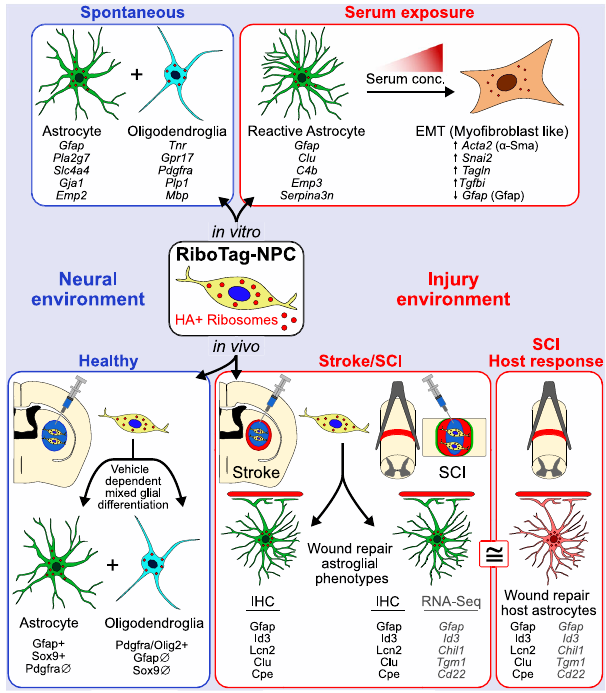
Fig.9|Schematicsummarizingthemain fi ndings. RiboTag-NPCwerederivedby neural induction of mESC and were used for RNA-Seq and IHC studies in vitro and in vivo. When placed into in vitro (top left) or in vivo (bottom left) neural envir- onments, RiboTag-NPC spontaneously differentiated into mixed populations of astrocyte lineage and oligodendrocyte lineage cells. Glial cell differentiation was veri fi ed based on gene expression determined by bulk RiboTag RNA-Seq and single-nuclei RNA-Seq. Introducing NPC into CNS injury-like environments in vitro (via exposure to increasing concentrations of serum (top right) or grafting in vivo into lesion environments after stroke and spinal cord injury (bottom right), instructed cells to adopt wound repair astroglial phenotypes through non-cell autonomouscues.Thewoundrepairastroglialphenotypeadoptedbygrafted NPC inCNSinjuriessharednumerousproteinandtranscriptomesimilarities( ≅ )withthe host astrocyte wound repair response (bottom right).Example proteins and genes (italicized) shared by these wound repair phenotypes are listed. Notably, high serum concentrations in vitro (top right), or grafting into larger and more severe lesions (not depicted), increased myo fi broblast-like phenotypes in NPC char- acteristic of EMT. EMT epithelial mesenchymal transition, HAhaemagglutinin, IHC